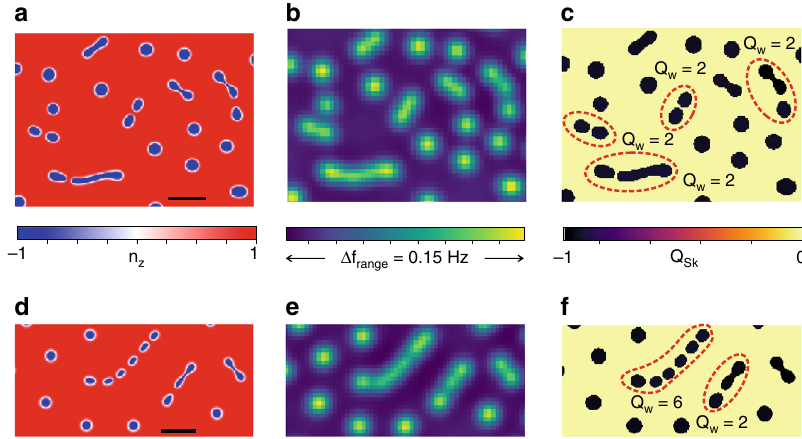
Fig. 4 Micromagnetic simulations of magnetic textures (Supplementary Note 5) for two sets of magnetic parameters corresponding to 5 and 200 K: a – c A = 11pJ/m, D = 2mJ/m 2 , M s = 1.34 MA/m, K eff = 0.2 MJ/m 3 , and d – f A = 11 pJ/m, D = 2 mJ/m 2 , M s = 1.16 MA/m, K eff = 0.05 MJ/m 3 . a , d 2D maps of the out-of-plane magnetization ( n z ) at 0.230 T. b , e Simulated MFM images at h = 40 nm obtained by integrating the stray fi eld from the micromagnetic simulations and convolving with a model for the tip (Supplementary Note 5). c , f Contribution to the topological charge from each domain, calculated using Eq. (1) (Supplementary Note 5). Dashed lines highlight trains of skyrmions which appear as individual worms in the MFM scans. [The scale bars in a and d are 200 nm]